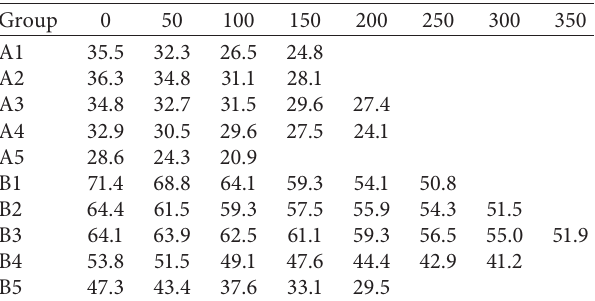
Table 10: Compressive strength of concrete after different freeze- thaw cycles.